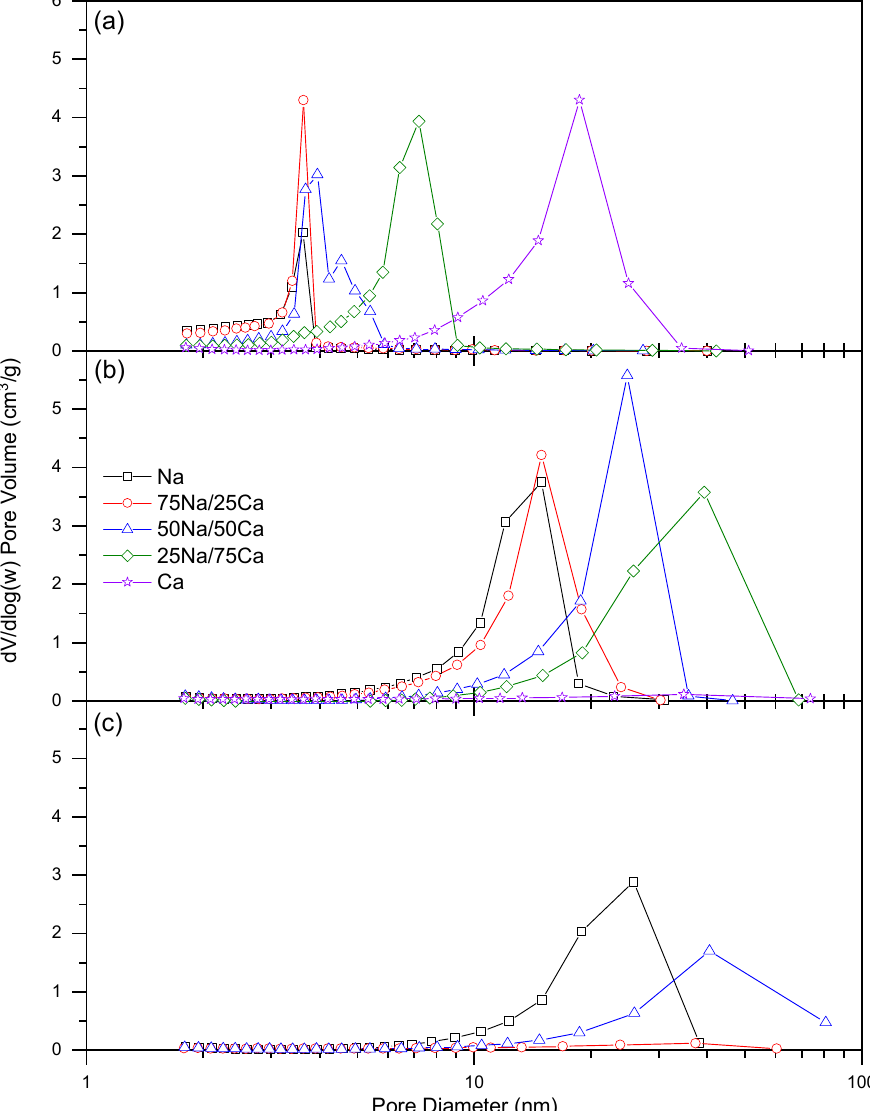
Figure 3. The pore size distributions obtained for the resorcinol–formaldehyde xerogels produced using a 20% solids content and ( a ) R/C 100, ( b ) R/C 400, and ( c ) R/C 600.